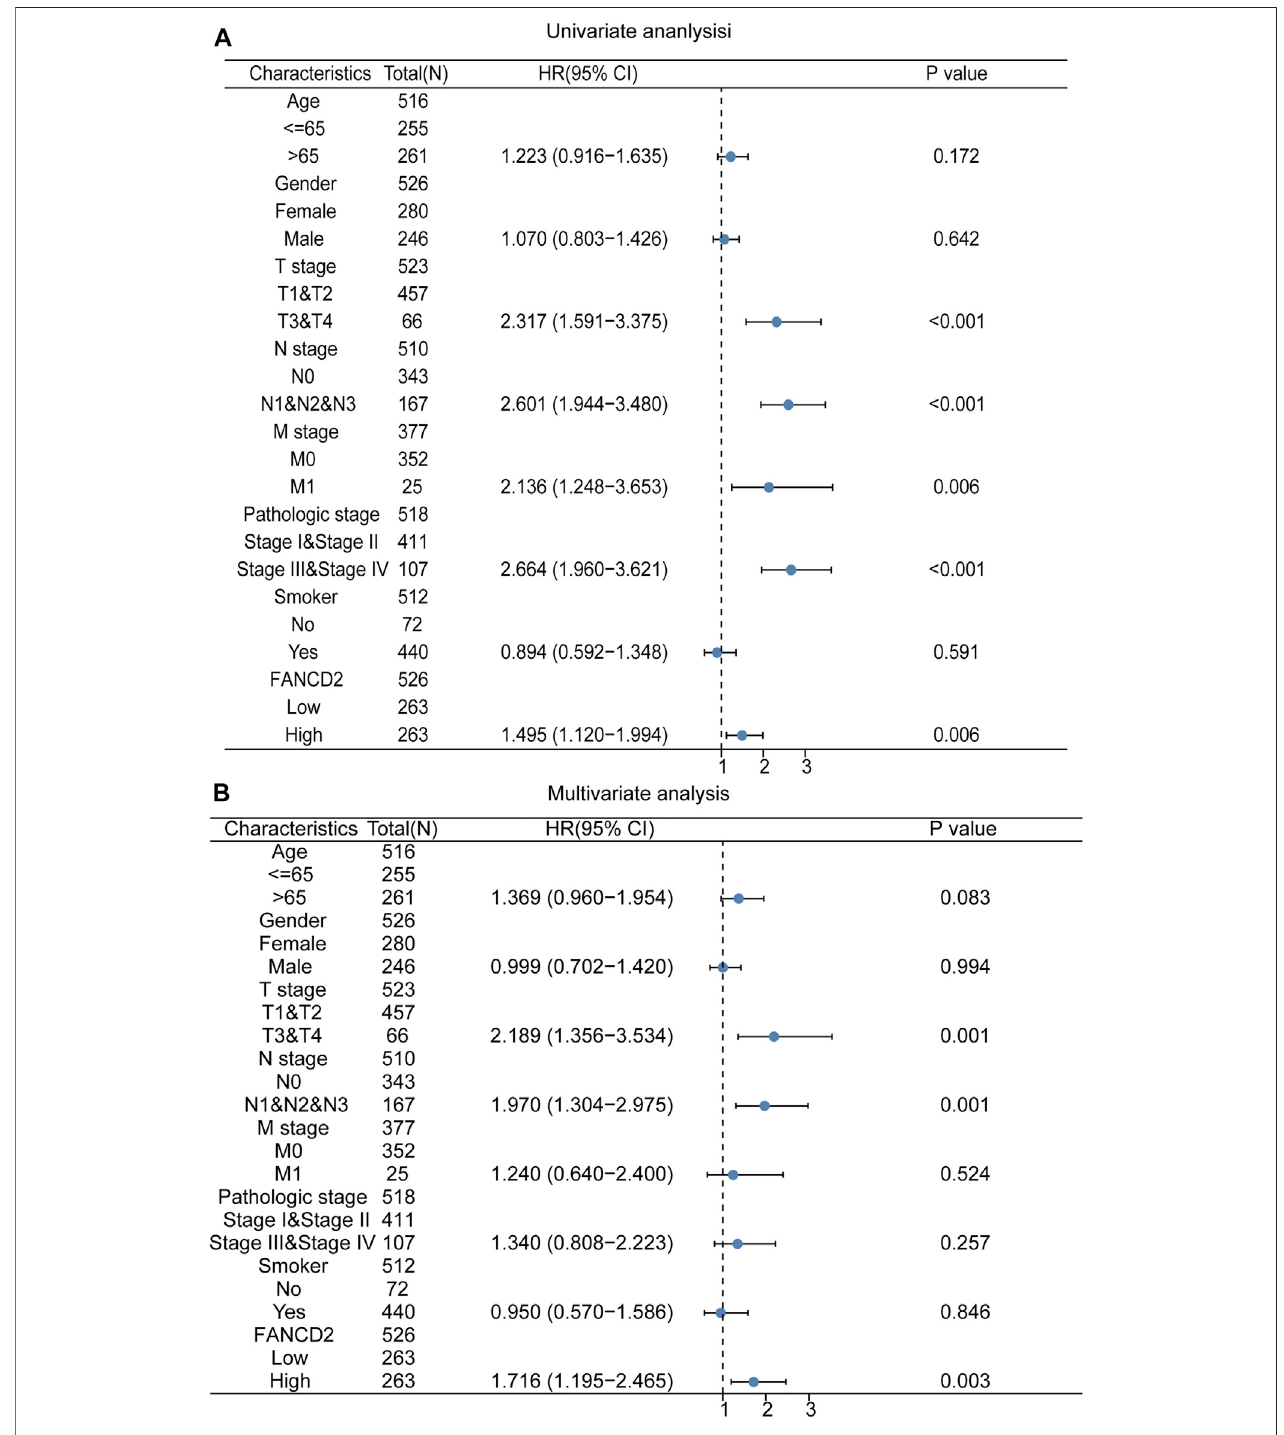
FIGURE 5 | Univariate (A) and multivariate (B) analyses of FANCD2 expression and important clinicopathological parameters concerning prognosis among Patients with LUAD.